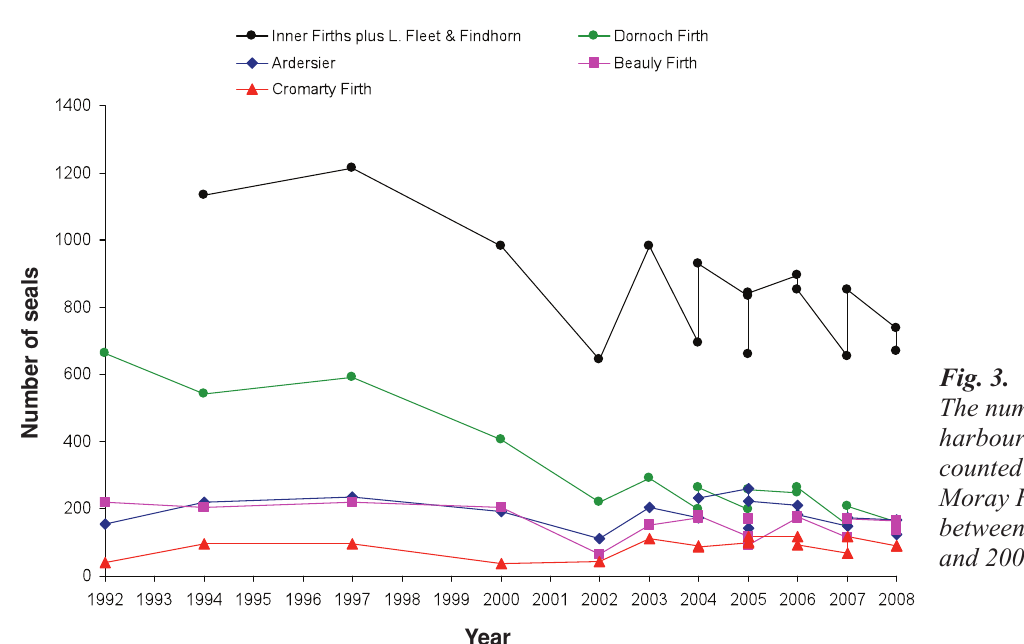
Fig. 3. The number of harbour seals counted in the Moray Firth, between 1992 and